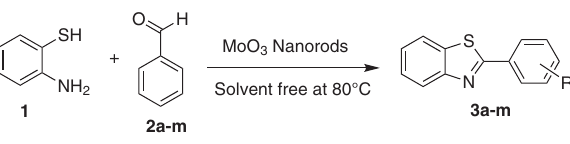
Figure 1: UV-visible Spectrum of MoO 0.1 M tetra butyl ammonium bromide (TBAB) at 18 mA current